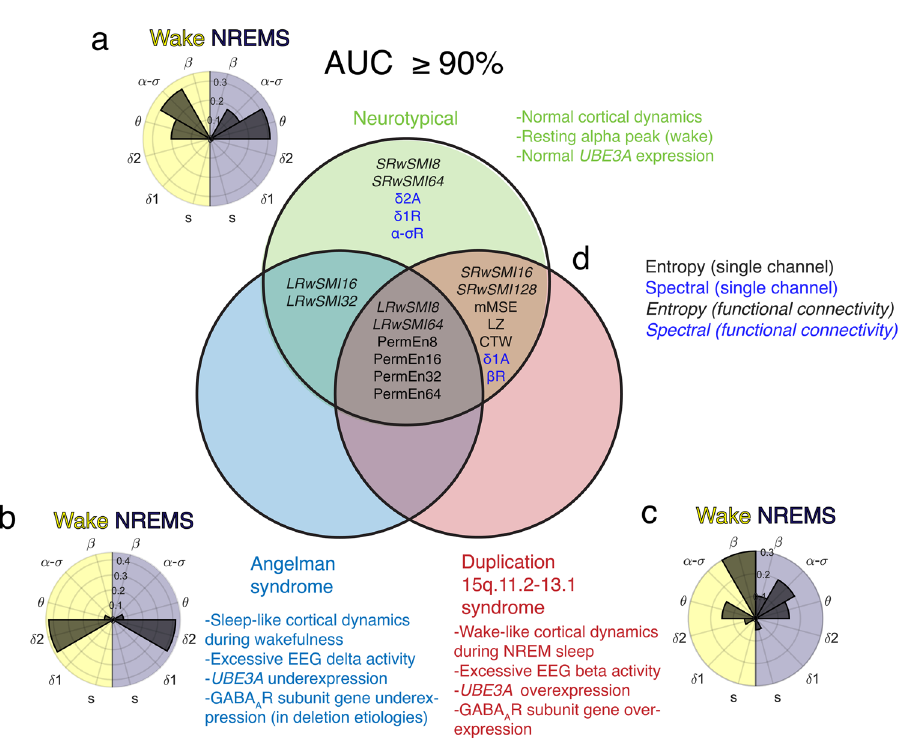
Fig. 2 EEG entropy measures of neural complexity are the common denominator of consciousness under conditions of both normal (neurotypical) and abnormal (Angelman syndrome, Duplication 15q11.2-13.1 syndrome) cortical dynamics. The above histograms report the modal peak frequency across channels for NT children ( a ), children with AS ( b ), and children with Dup15q ( c ). The Venn diagram reports EEG features that yield an area under the receiver operating characteristics curve (AUC) ≥ 90% for NT children (green circle, a ), children AS (blue circle, b ), and children with Dup15q (red circle, c ). Abbreviations of entropy features are written in black font, spectral features in blue font, and functional connectivity (FC) features in italicized font. The intersection of all three groups is reported in ( d ) and contains only entropy features, thus demonstrating that entropy is a common denominator of consciousness across different populations with diverse cortical dynamics. Source data are presented in Supplementary Data 2 (a, b, c) and Supplementary Data 3 (d). NREMS Non-rapid eye movement